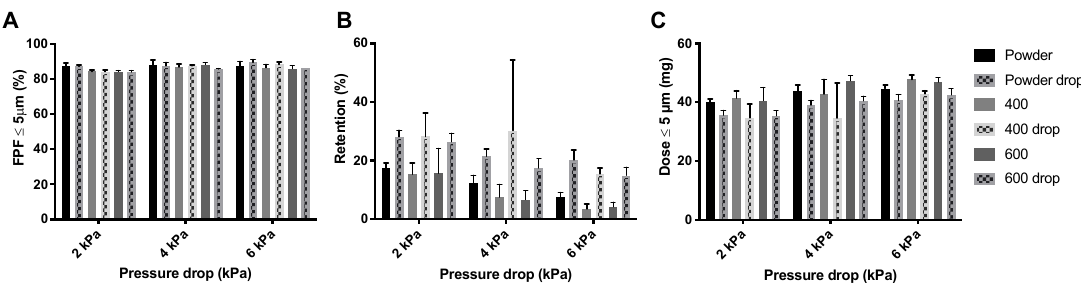
Figure 11. Effect of the drop test on the dispersion of 57 mg amikacin by the Cyclops ® . Panel ( A ) shows the FPF of the different products before and after the drop test, panel ( B ) shows the retention and panel ( C ) shows the FPD (average ± SD, n = 5). The FPD is calculated by multiplying the FPF with the emitted dose (=FPF × (1 − retention)).